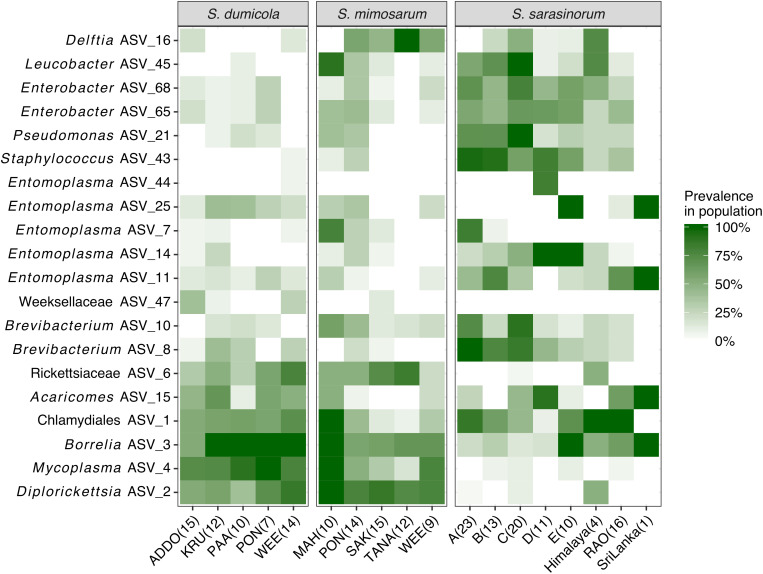
Heatmap of the core and dominant ASVs across the three social Stegodyphus species. Each column represents a population. The prevalence in a population is calculated as percent of individual spiders with a given ASV (presence threshold: Relative abundance ≥ 0.01%). The number of spider individuals in each population is shown in brackets.